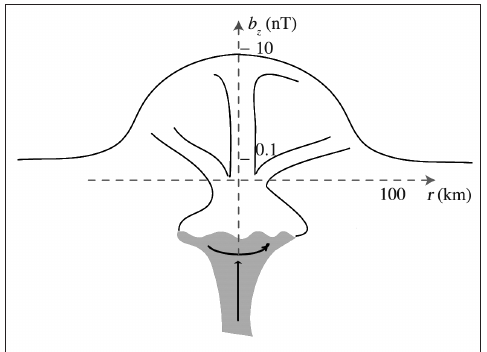
Fig. 1. Oscillations and waves in a volcano capaci- ty. The magnetic field b z induced by the vortex in the volcano